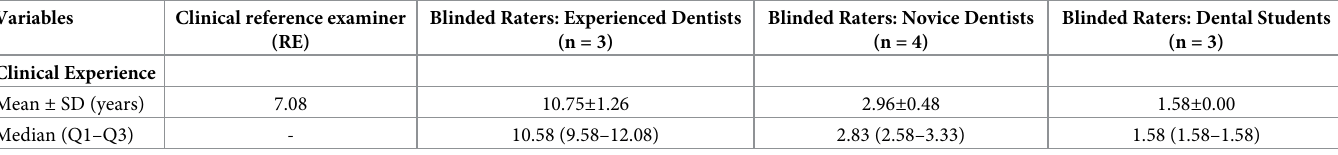
Table 1. Examiners’